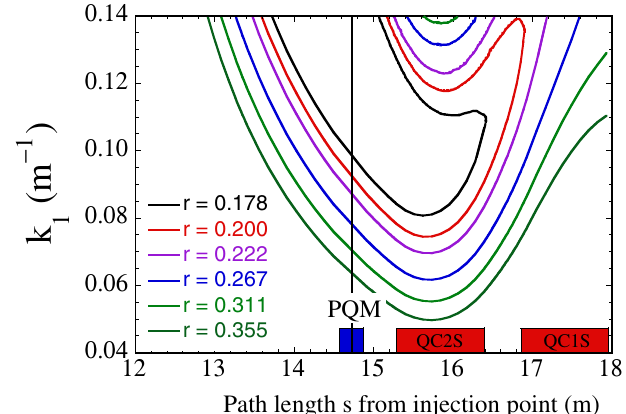
FIG. 10. (Color) Same as Fig. 10, but the rectangular region in Fig. 10 is enlarged and the quadrupole magnets QC1S and QC2S and the PQM are shown together. The perpendicular solid line indicates the center of the PQM.